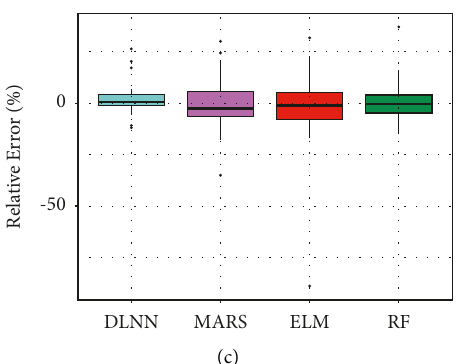
Figure 12: Relative error percentages of the developed AI models for the three tested scenarios. (a) Scenario I. (b) Scenario II. (c) Scenario